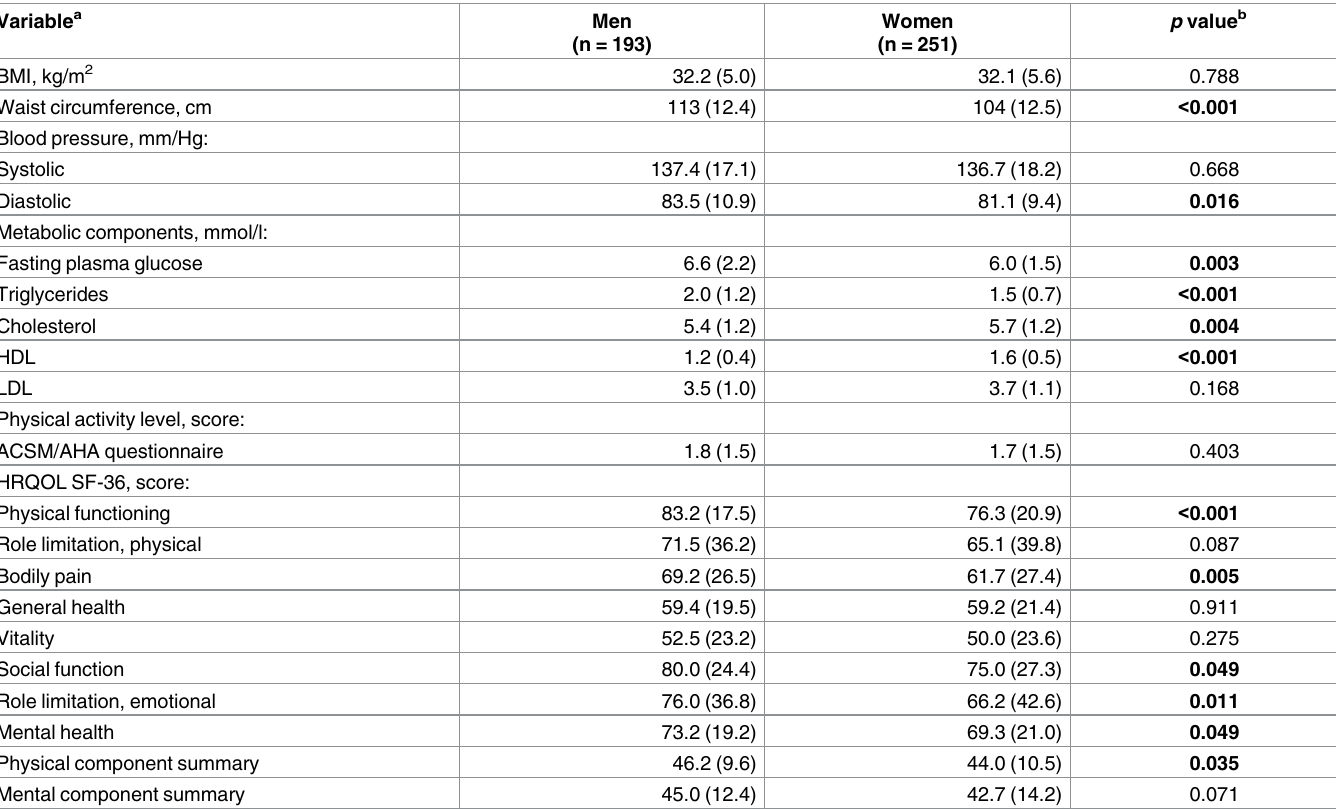
Table 3. Baseline characteristics in anthropometrics, metabolic risk factors, physical activity level and health related quality of life—Men and